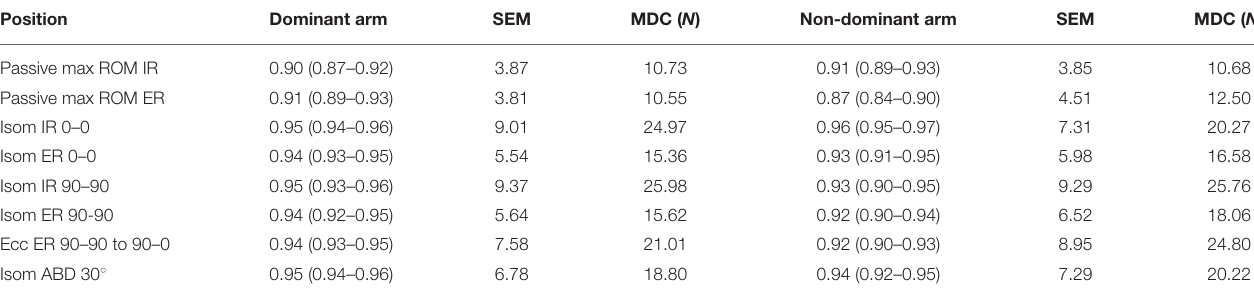
TABLE 2 | Intraexaminer reliability (ICC 3,k ) with their 95% CI, SEM and MDC (N) for the range of motion, isometric, and eccentric strength testing of the rotator cuff. Position Dominant arm SEM